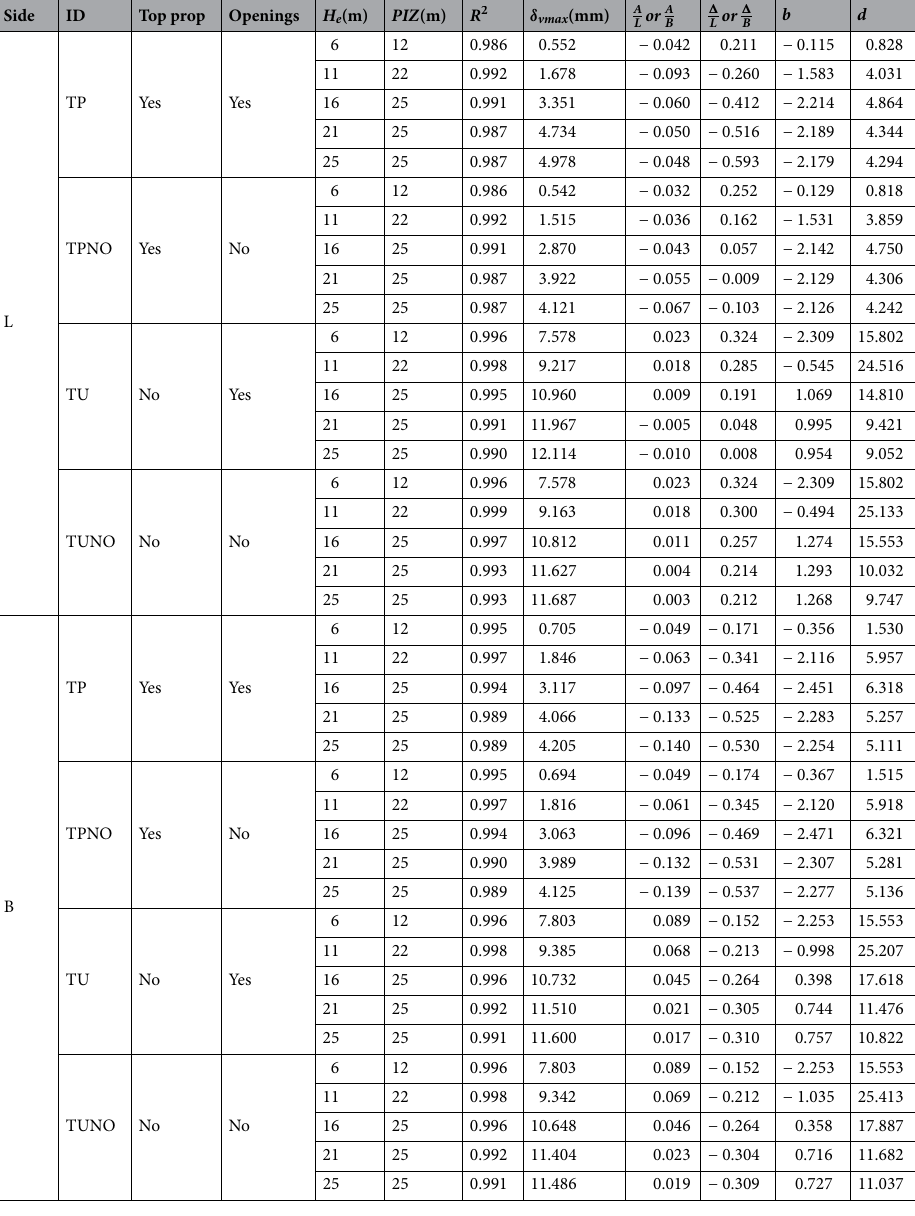
Table 5. Fitting